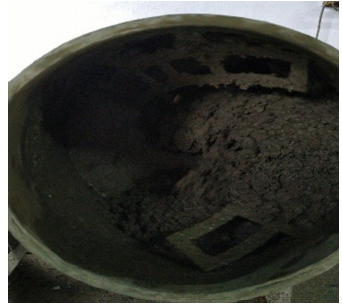
Figure 2. CFA-based concrete.